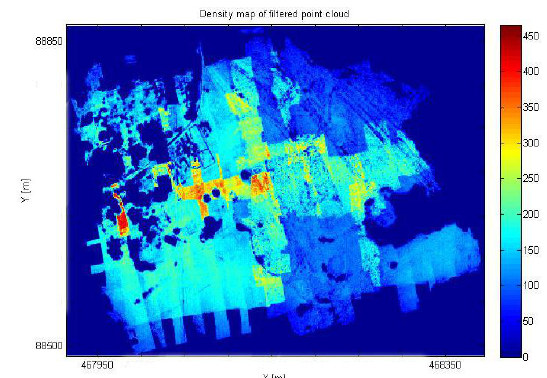
Figure 10. Density plot of filtered point